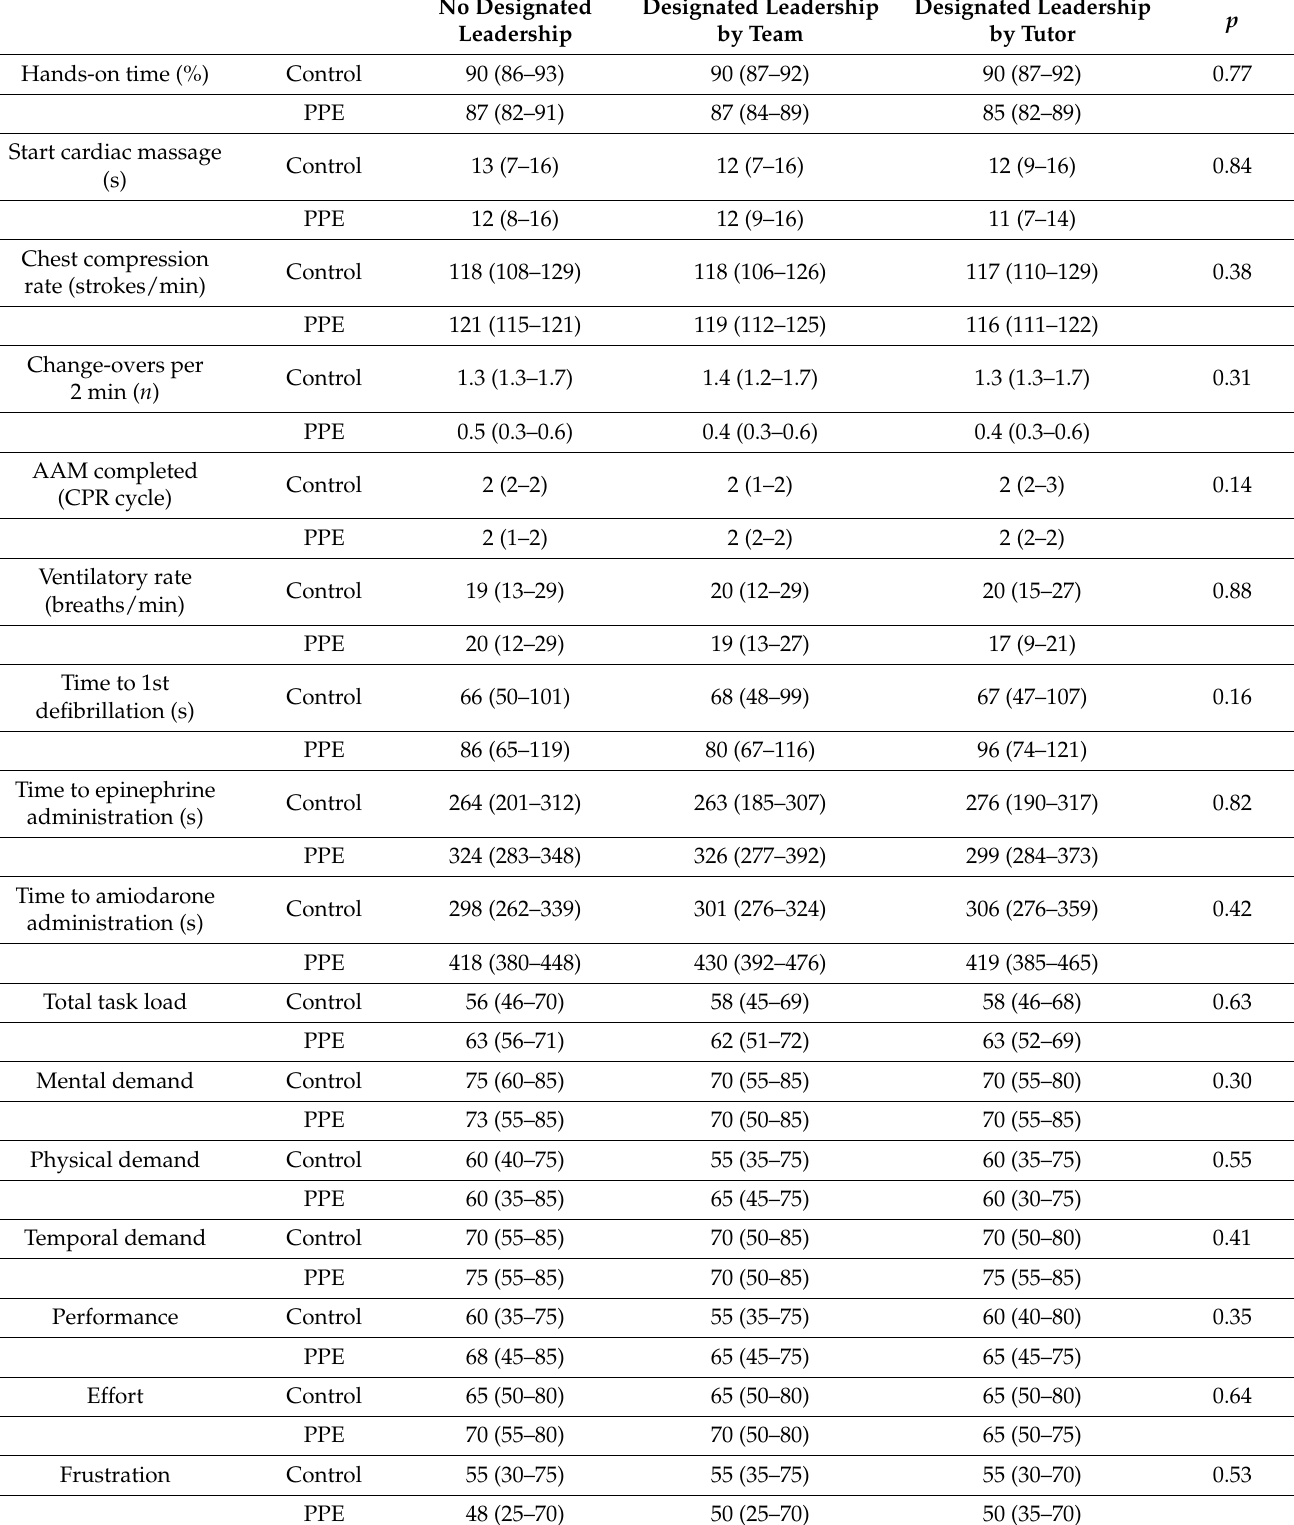
Table 2. Effects of leadership on primary and secondary